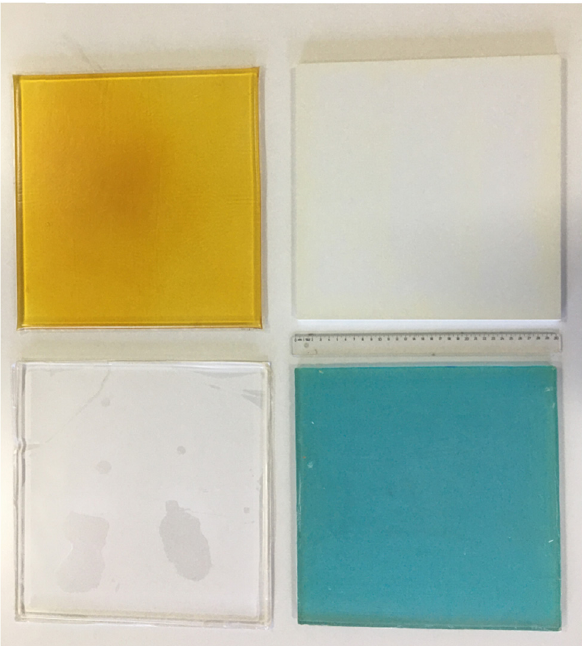
Figure 1: The typical view of the RW3 slab water - equivalent phantom ( upper right ) and some of the bolus materials ( length of ruler is 30 cm )